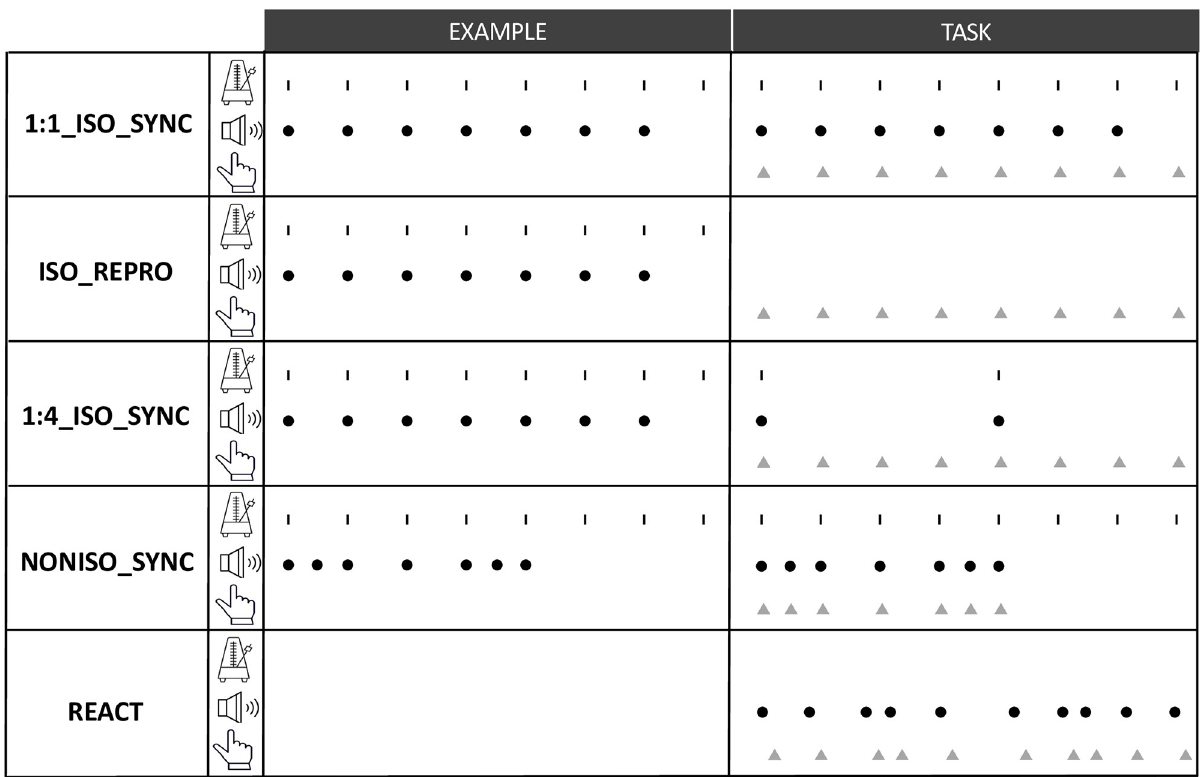
Fig 1. Summary of the five tasks: 1:1_ISO_SYNC—Synchronization task with a quadruple metered isochronous pattern; 0:1_ISO_REPRO– Reproduction, without any external reference, of a quadruple metered isochronous pattern, after listening passively to it; 1:4_ISO_SYNC: Synchronization task with a quadruple metered isochronous pattern, where only the strong beats (one every four) were marked by an auditory stimulus; NONISO_SYNC—Synchronization task with a quadruple metered non-isochronous pattern; REACT–Reaction task to an unpredictable and aperiodic pattern. The small lines indicate the metronome beats of an 8- beat cycle. The black dots indicate the auditory stimuli that were played to the participants. The grey triangles indicate the participants finger taps.